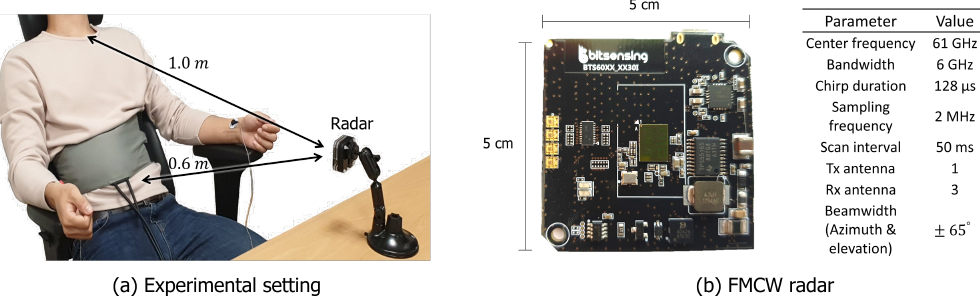
Figure 1. Vital-sign measurement using FMCW radar. ( a ) Experimental settings for vital measurement; ( b ) FMCW